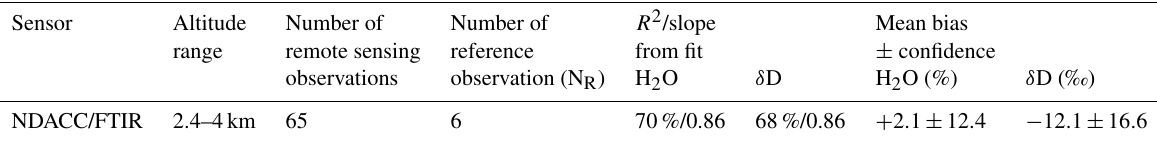
Table 2. Empirical validation and bias assessment of the NDACC/FTIR and MetOp/IASI H 2 O and δ D products in the middle troposphere. Sensor Altitude Number of Number of R 2 /slope Mean bias range remote sensing reference from fit ± confidence observations observation (N R )